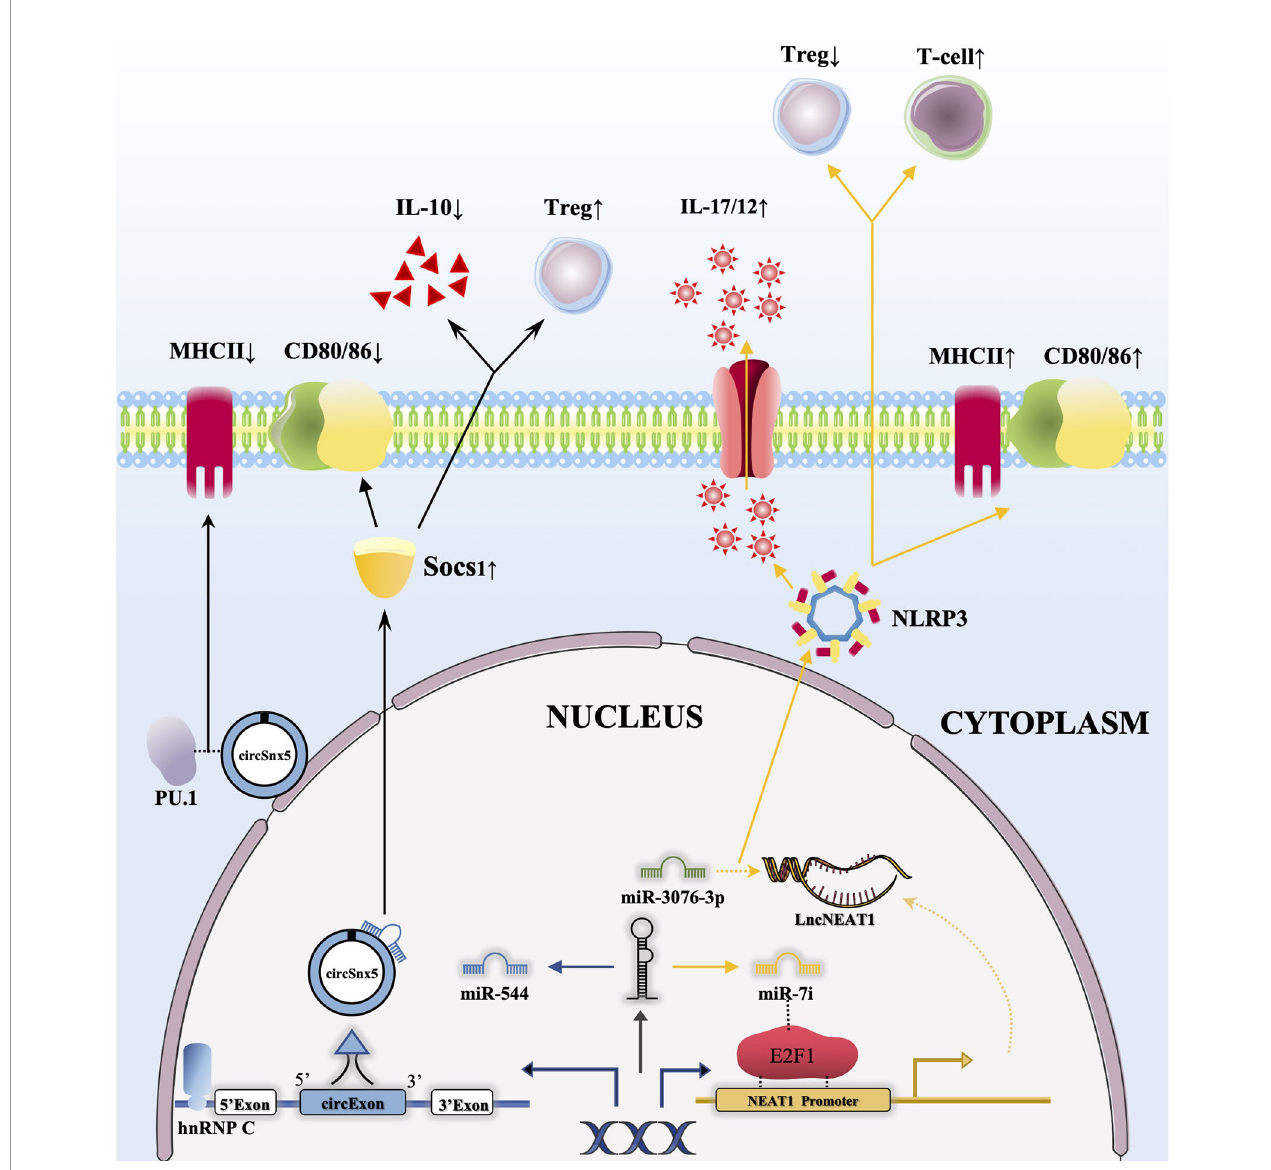
FIGURE 2 | CircRNAs and lncRNAs regulate the function of DCs through the ceRNA network. 1) The combination of hnRNP C with circSnx5 promotes the expression of circSnx5 in DCs, and circSnx5 sponging with miR-544 reduces the inhibitory effect of miR-544 on Socs1, thus reducing the expression of CD80/86 and the secretion of IL-10 and increasing the number of Tregs. In addition, circSnx5 combined with PU.1 can directly reduce the expression of MHCII ; 2) miRNA let- 7i can regulate the expression of lncNEAT1 by binding E2F1, and lncNEAT1 is able to regulate NLRP3 in fl ammasome by inhibiting Mir-3076-3P, then increasing expression of MHCII/CD80/86, promoting secretion of IL-17/12 as well as reducing the number of Tregs and increasing the activation of T